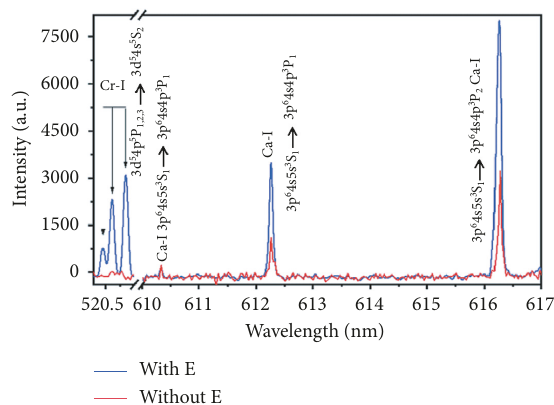
Figure 9: LIBS spectra of Euphorbia indica root with and without the electric field (adapted from [141]). Table 4: LIBS characterization for the detection of nutrients and toxic elements in